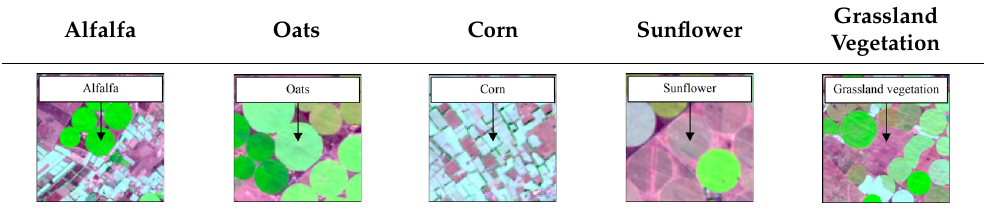
Table 6. Classification results based on SVM at the pre − wintering stage. Alfalfa Oats Corn Sunflower Grassland Vegetation Alfalfa 71 1 4 0 0 Oats 0 31 0 0 0 Corn 0 5 35 0 0 Sunflower 0 0 0 6 0 Grassland 0 0 0 4 vegetation